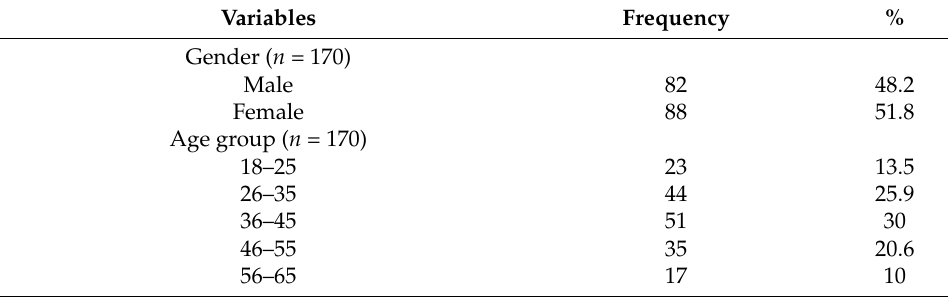
Table 1. Demographic Characteristics of Participants (N =